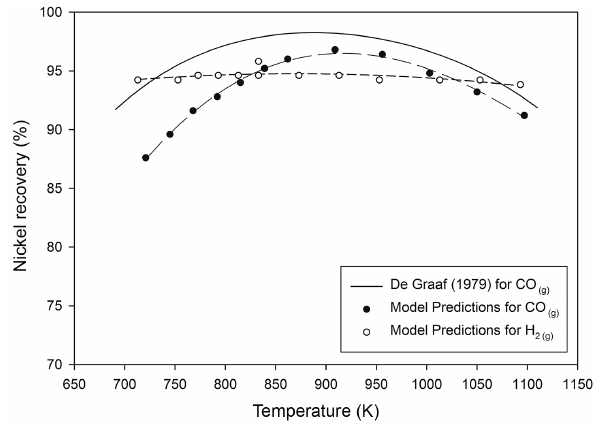
Figure 16: Comparison of the model predictions for the hydrogen reduction of Manuran ore with those previously predicted for carbon monoxide and also the experimental results of de Graaf for reduc- tion in carbon monoxide [8,